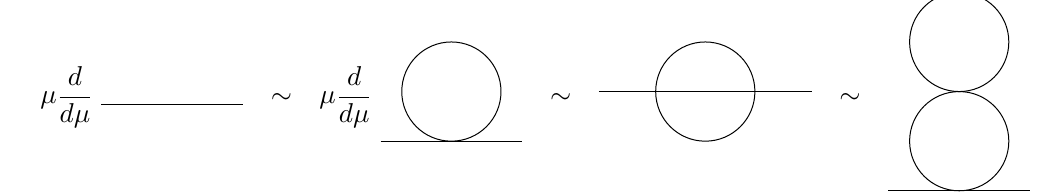
Figure 3. At high temperature, the running of tree-level parameters is the same order as the running of the one-loop thermal mass, which in turn is the same order as explicit logarithms of renormalisation scale at two-loop order. All these terms are of order O ( g 4 T 2 ) . where g, g 0 are SU(2) and U(1) gauge couplings, g is top Yukawa coupling (effect from Y other Yukawa couplings is numerically negligible), λ the Higgs self-interaction and λ p h the portal coupling between Higgs and scalar S . The numerical factor C depends on the representation of S under the gauge symmetries, for e.g. C = 2 / 3 in the real-singlet extended SM [80], C = 2 in the real-triplet extended SM [93] and C = 4 / 3 in the Two-Higgs Doublet Model (2HDM) [92].